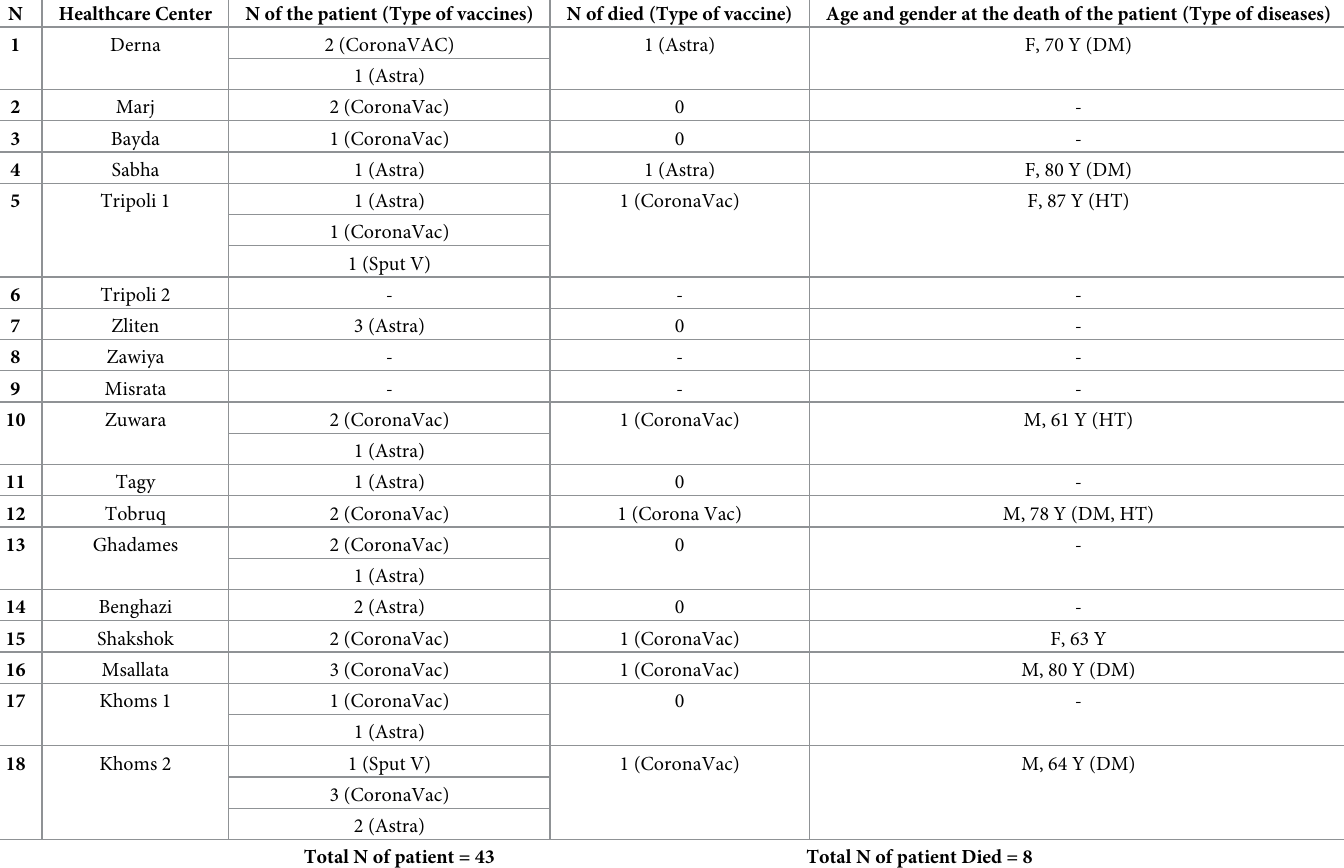
Table 2. Numbers of patients who were admitted to healthcare centers or hospitals after receiving one dose of vaccine in Libya. N: Number DM: Diabetic HT: Hyper- tension CoronaVac: Sinovac Astra: Oxford/AstraZeneca SputV: Sputnik v (-) = Data not